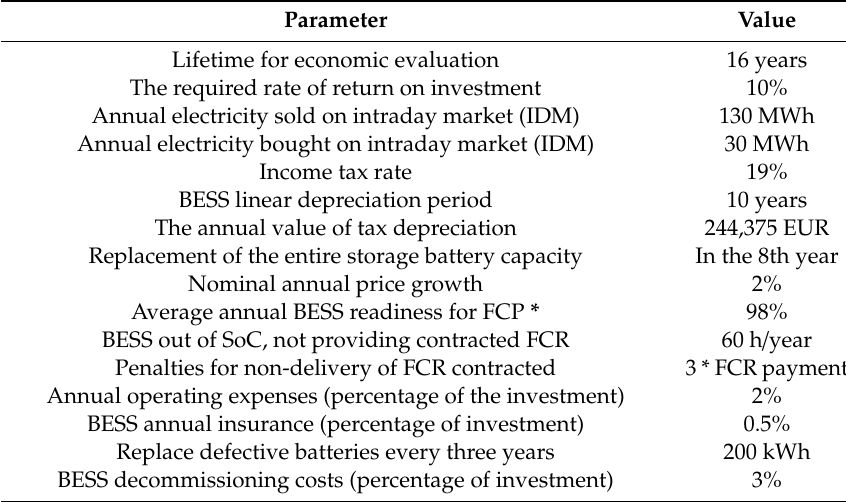
Table 9. Overall economic model parametrization. Parameter